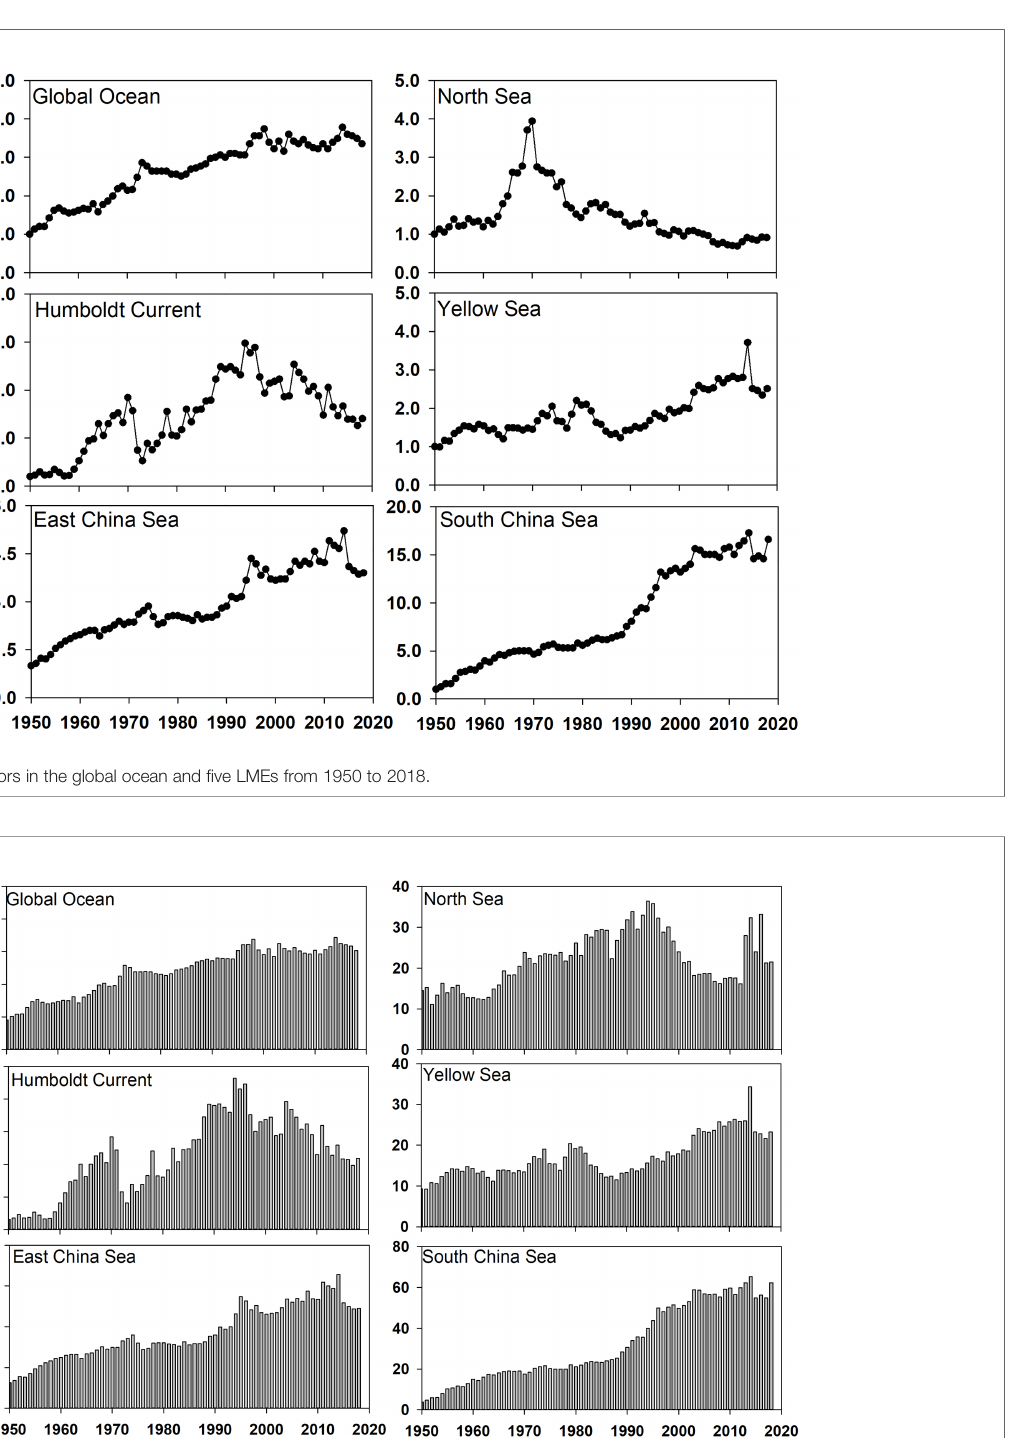
FIGURE 7 | The ratios of primary production required for fi sheries catch to the total primary production (%PPR) in the global ocean and fi ve LMEs from 1950 to 2018.